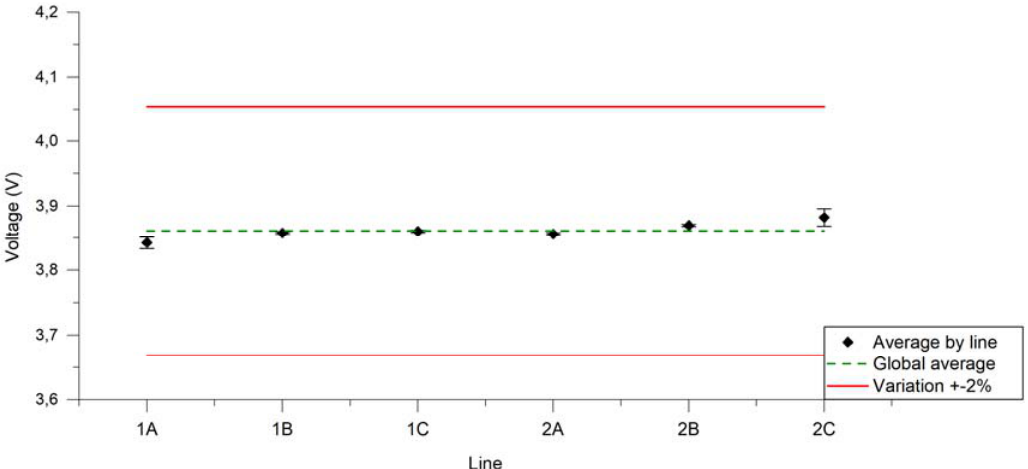
Figure 7. Average voltage applied from each U-SAV line over 100 puffs during 24 manipulations (dark dots). Red lines represent ±2%. Green line represents the average from all U-SAV lines.